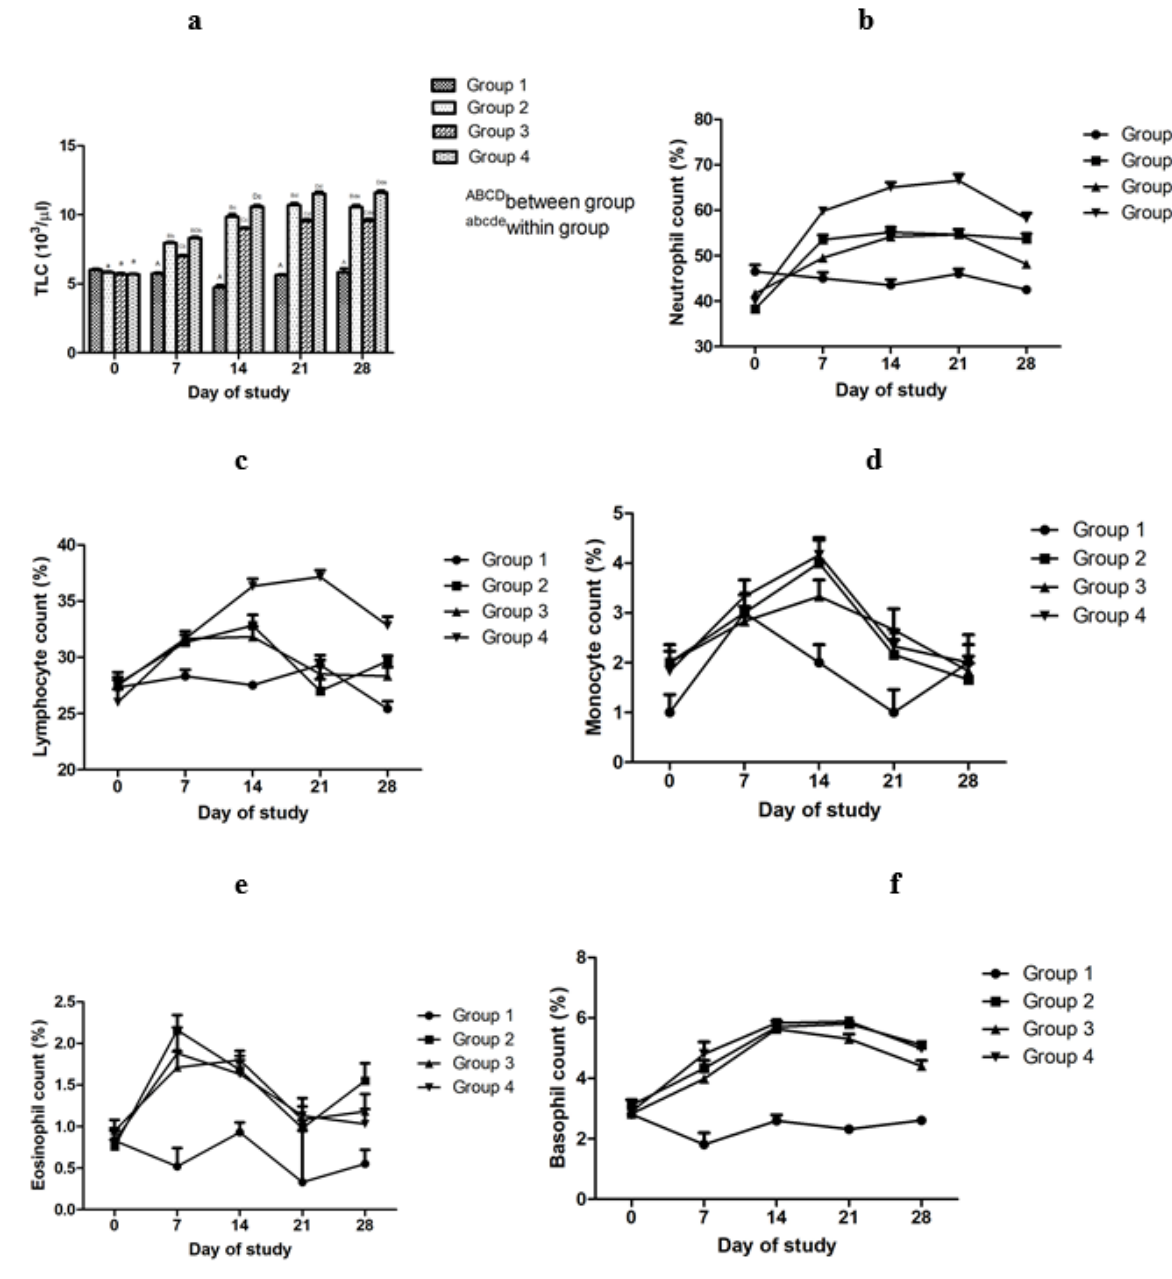
Figure 1. Effectof adjuvanted, sonicated antigens on leucocyte indices in rabbits. ( a ) Total leucocyte count (TLC) in 10 3 / µ L. ( b ) Neutrophil count in %. ( c ) Lymphocyte count in %. ( d ) Monocyte count